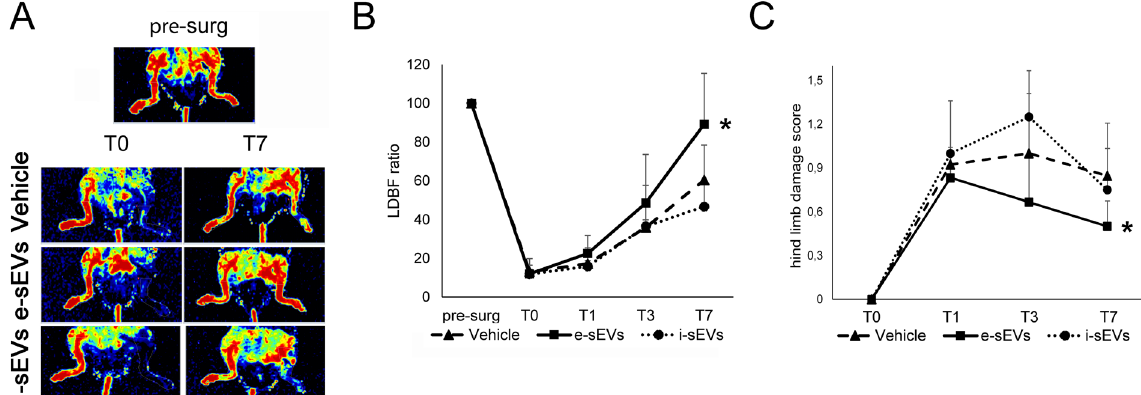
Figure 2. e-sEVs increase blood perfusion and reduced damage in ischemic hind limbs. ( A ) Representative images of Laser Doppler Blood Flow (LDBF) obtained prior (pre-surg) and immediately after intervention (T0) and at day 7 after surgery (T7) of mice treated with Vehicle, with e-sEVs and i-sEVs. ( B ) Quantitative analysis of blood perfusion measured by LDBF. Data are expressed as mean ± SD; * p < 0.05 (One-way ANOVA - Newman-Keuls Multiple Comparison Test) (n = 10). ( C ) Foot damage score was evaluated for the indicated times as reported in Methods. Data are expressed as mean ± SEM, n = 10 ( * p < 0.0 5 ischemic limb of e-sEVs mice vs ischemic limb of vehicle and i-sEVs